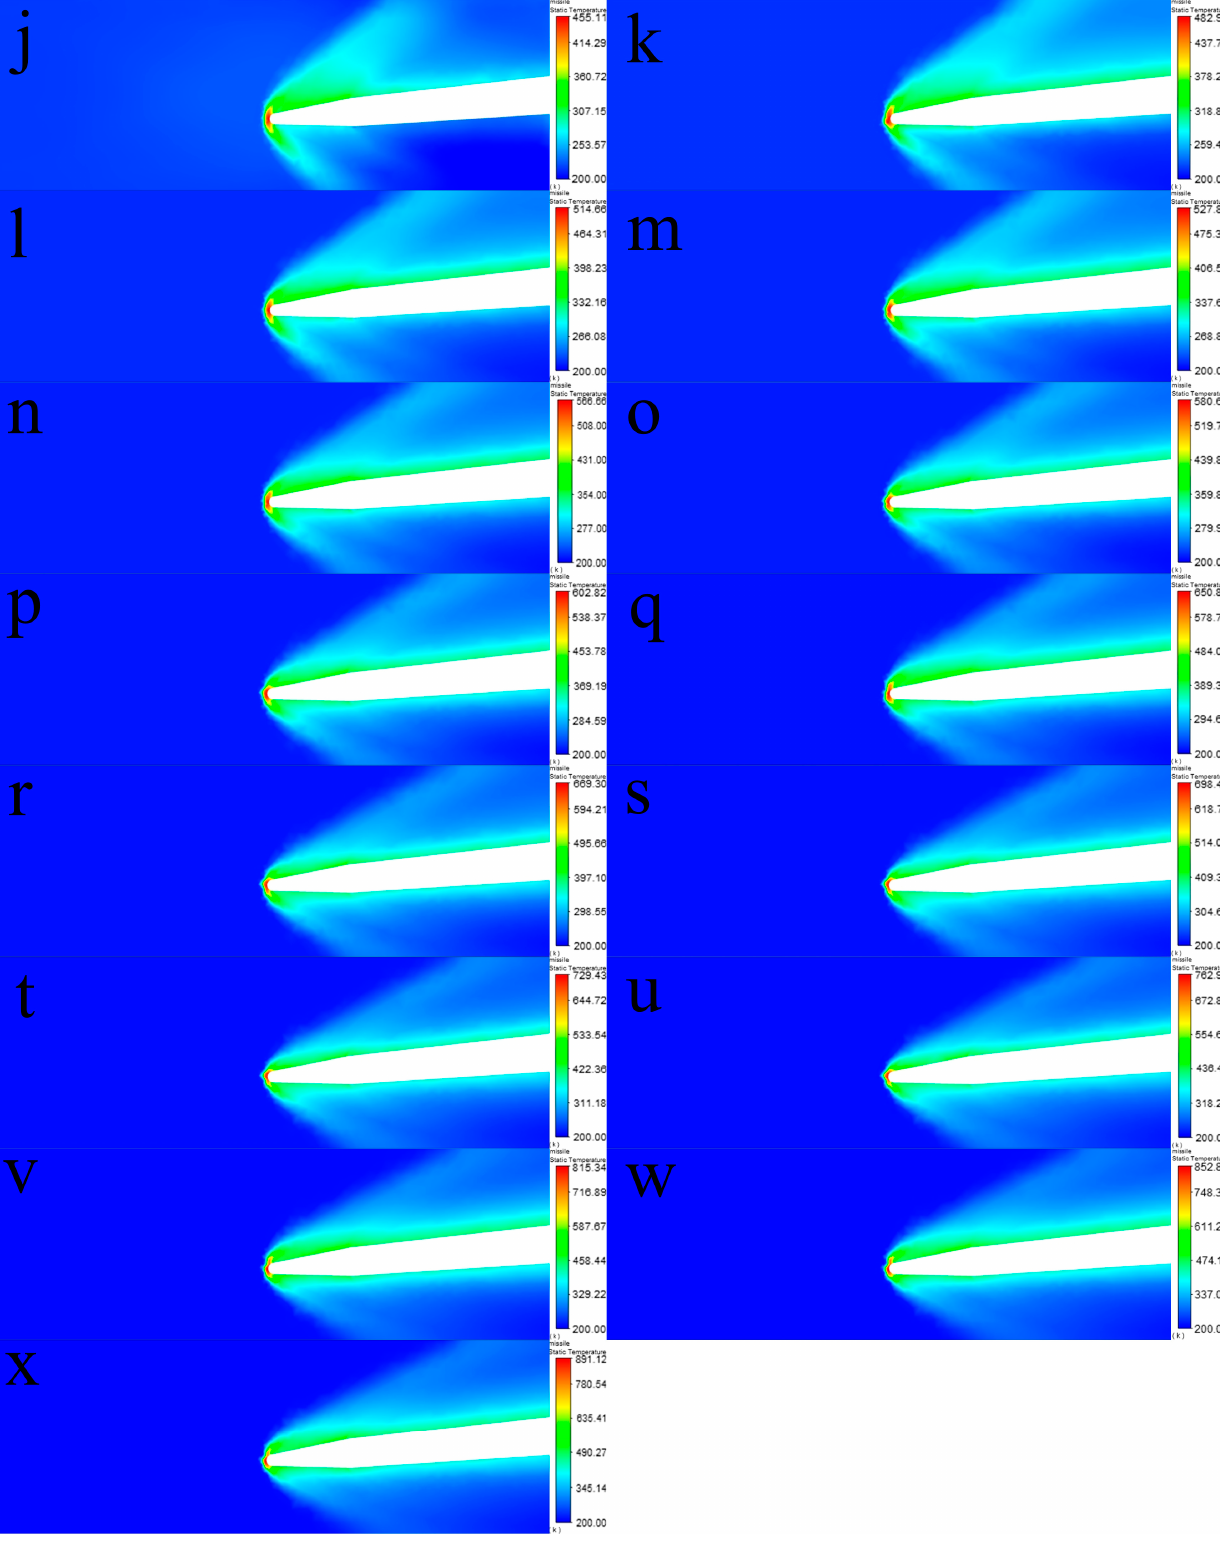
Figure 5. The contours of groups ( j – x ) with attack angle 5°.